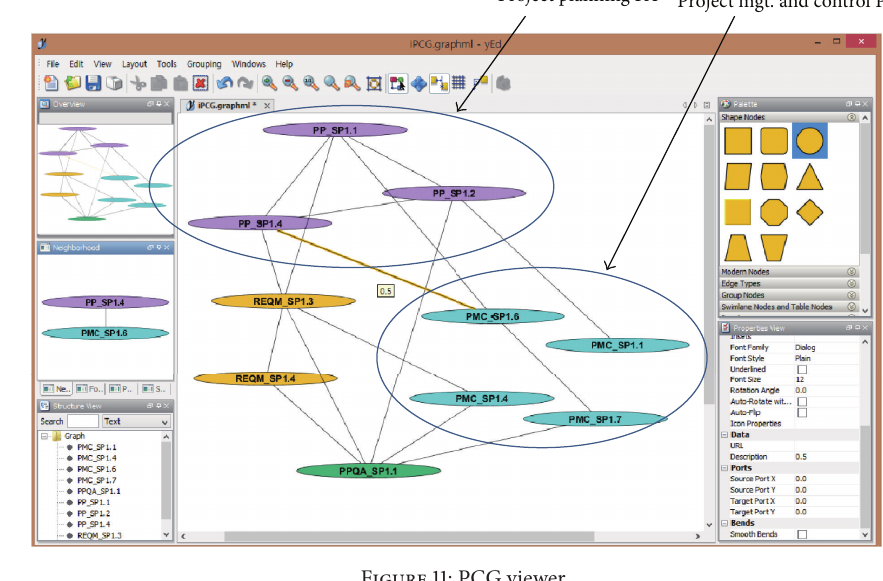
Figure 11: PCG viewer.